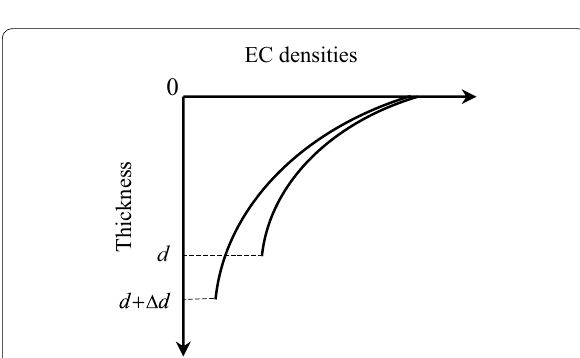
Figure 8 Illustration of EC densities in plates of different